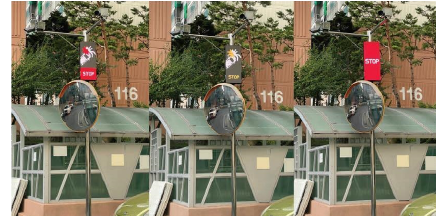
Figure 8: Collision risk warning as delivered by LED sign board. Tree diferent images are displayed sequentially until a risk situation is over.